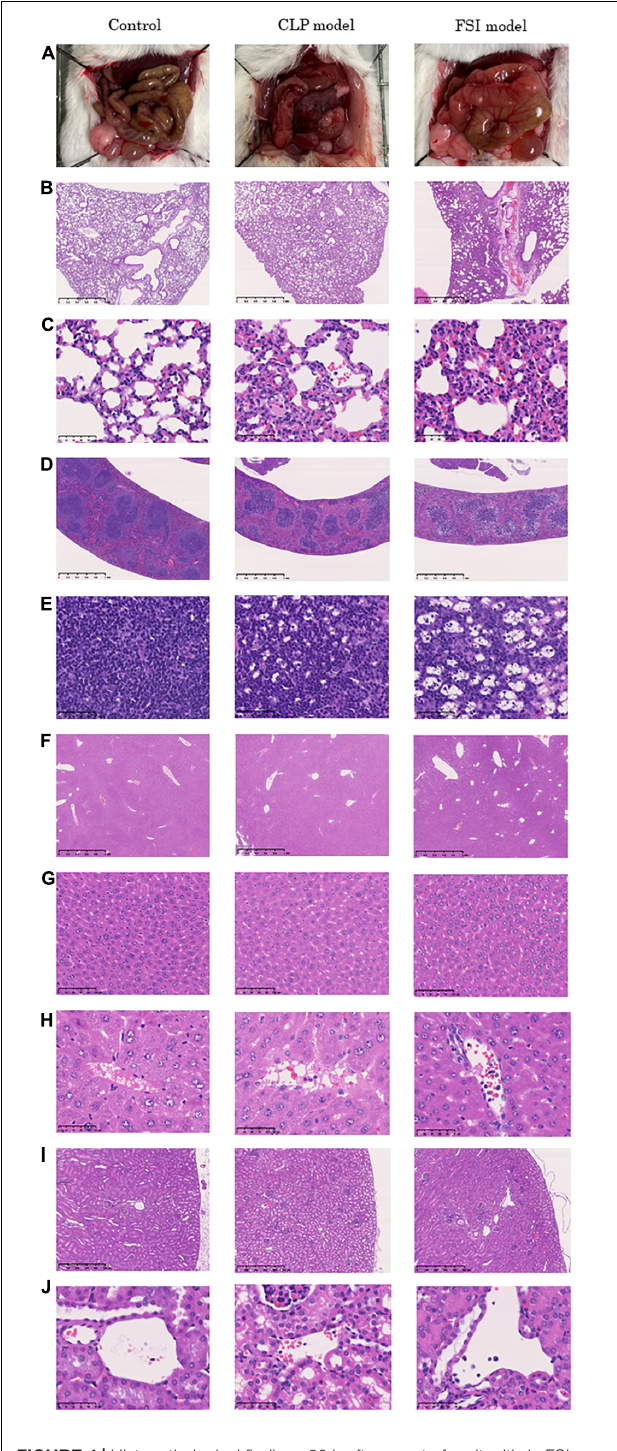
FIGURE 4 | Histopathological findings 20 h after onset of peritonitis in FSI model, CLP model and control cases. (A) Microscopic findings of the abdominal cavity. (B) 2.5 × (Objective lens) lung tissues. (C) 40 × (Objective lens) lung tissues. (D) 2.5 × (Objective lens) spleen tissues. (E) 40 × (Objective lens) spleen tissues. (F) 2.5 × (Objective lens) liver tissues. (G) 20 × (Objective lens) liver tissues. (H) 40 × (Objective lens) liver tissues. (I) 5 × (Objective